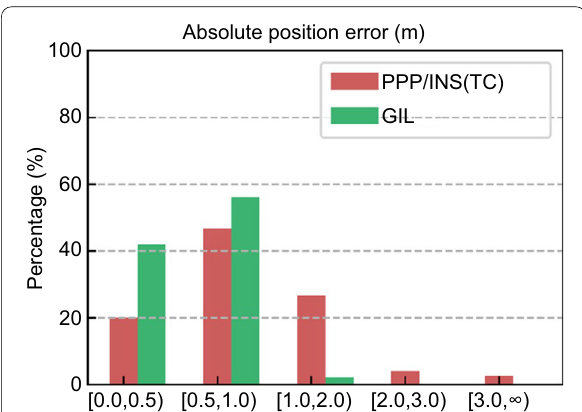
Fig. 8 Distribution of absolute position offsets of the multi-GNSS PPP/INS and GIL methods in GNSS partly-blocked